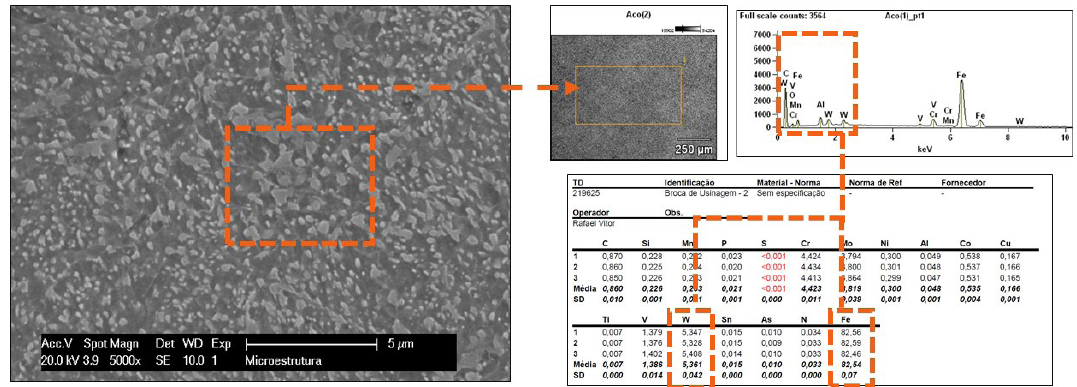
Figure 3. MEV analysis of AISI M35